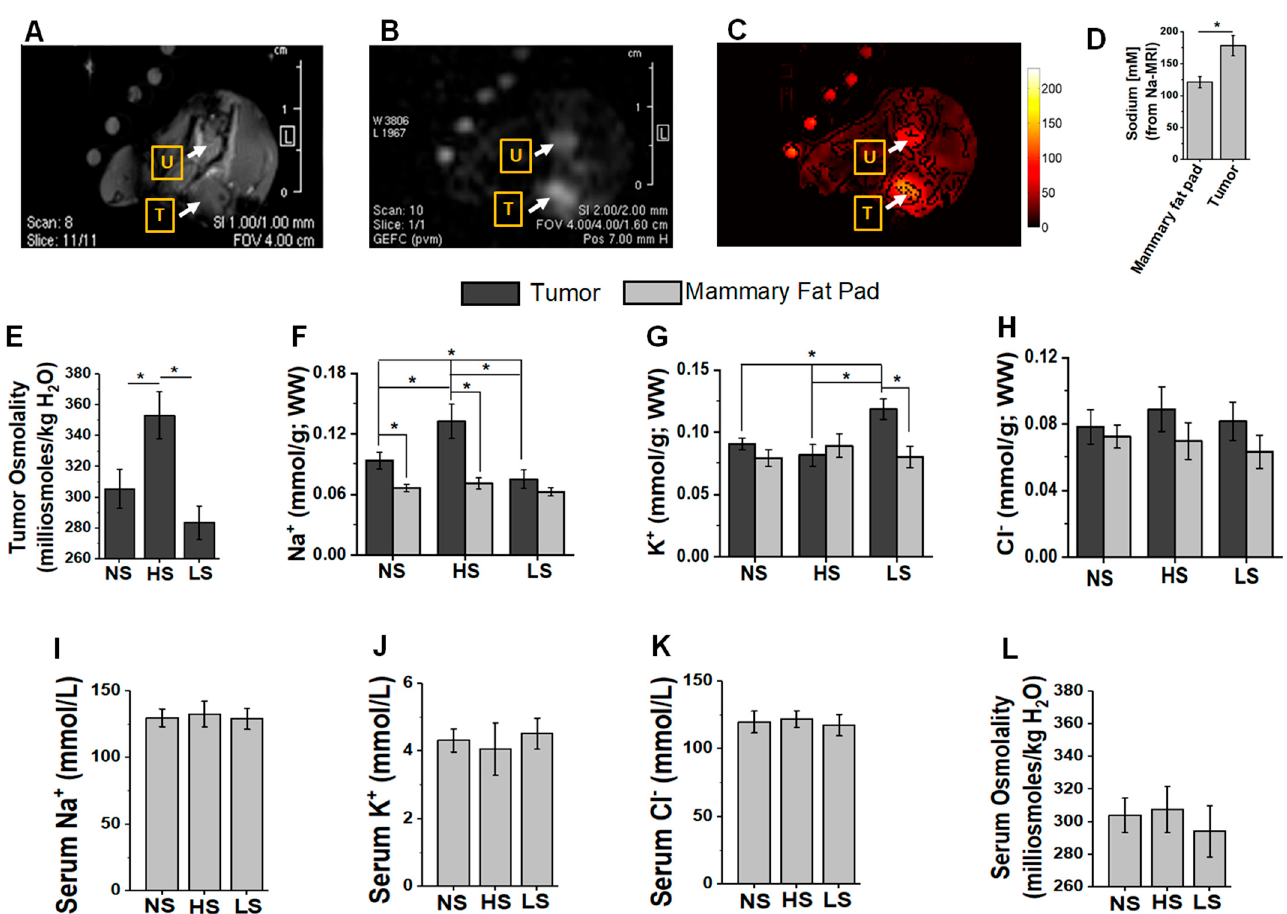
Figure 1. Sodium MRI in vivo live imaging of Py230-C57Bl/6 breast tumor. Py230 breast tumor cells were injected into right mammary fat pad in 8-week-old female C57Bl/6 mice. The imaging